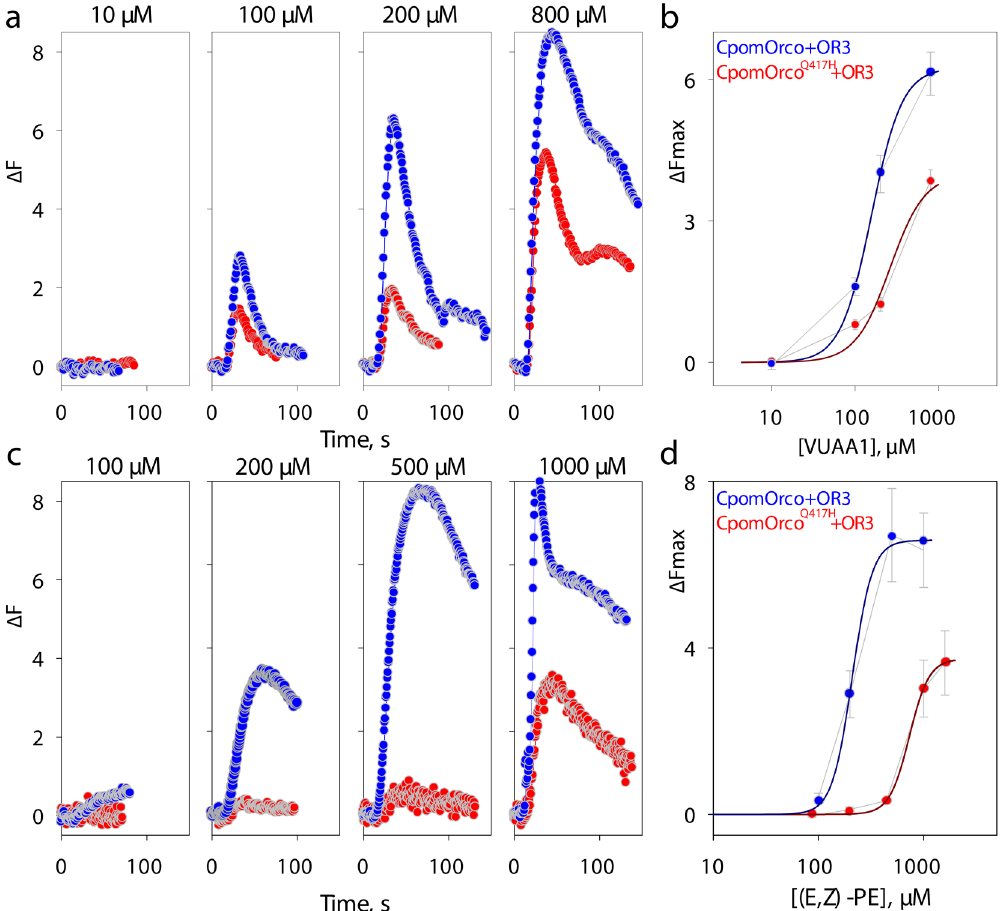
Figure 3. Comparison of HEK cell responses expressing wild-type and mutagenized form of Orco. ( a )— Universal Orco agonist, VUAA1, elicits dose-dependent Ca ++ i increase in HEK293A cells expressing either CpomOrco (blue) or CpomOrco Q417H (red). ( b )—VUAA1 concentration dependencies. Data points represent the mean response amplitudes (± SE). Data were fit to a Hill equation for CpomOrco (blue smooth line) or CpomOrco Q417H (red smooth line) respectively, providing maximum responses of ~ 6.3 ± 0.1 and ~ 3.9 ± 1.3 ∆F, EC50s of ~ 157.1 ± 3.58 and ~ 261.8 ± 165.6 µM and Hill coefficients of ~ 2.4 ± 0.1 and ~ 2.1 ± 1.9; total number of cells analysed: N = 123 and 94. ( c )—Effects of Pear ester on the activity of CpomOrco+OR3 (blue) and CpomOrco Q417H +OR3 (red) heteromers. ( d )—Pear ester concentration dependencies. Data points represent the mean response amplitudes (± SE) of cells from at least three experiments. Data were fit to a Hill equation providing the following parameters: maximum responses of ~ 6.6 ± 0.3 and 3.7 ± 0.1 ∆F; EC50s of ~ 210 ± 14.2 and ~ 733.5 ± 26.9 µM; Hill coefficients of ~ 4.6 ± 2.4 and ~ 4.6 ± 0.4, for CpomOR3/CpomOrco (blue smooth line) or CpomOR3/CpomOrco Q417H (red smooth line) respectively. Total number of cells analysed: N = 160 and 262. Traces in A and C represent the mean responses of cells from one experiment. Data in B and D were not normalized. Scales in B and D are